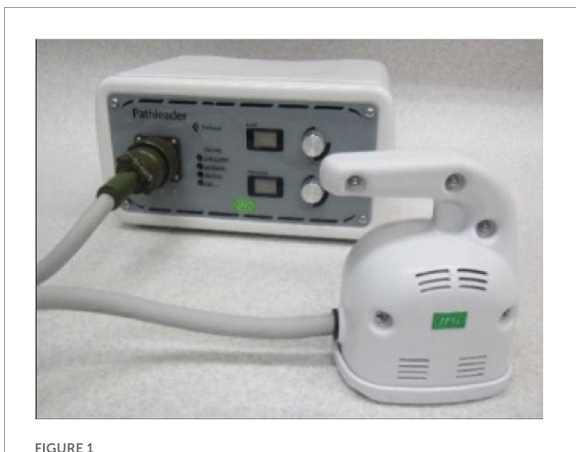
FIGURE1 A photo of a repetitive peripheral magnetic stimulation